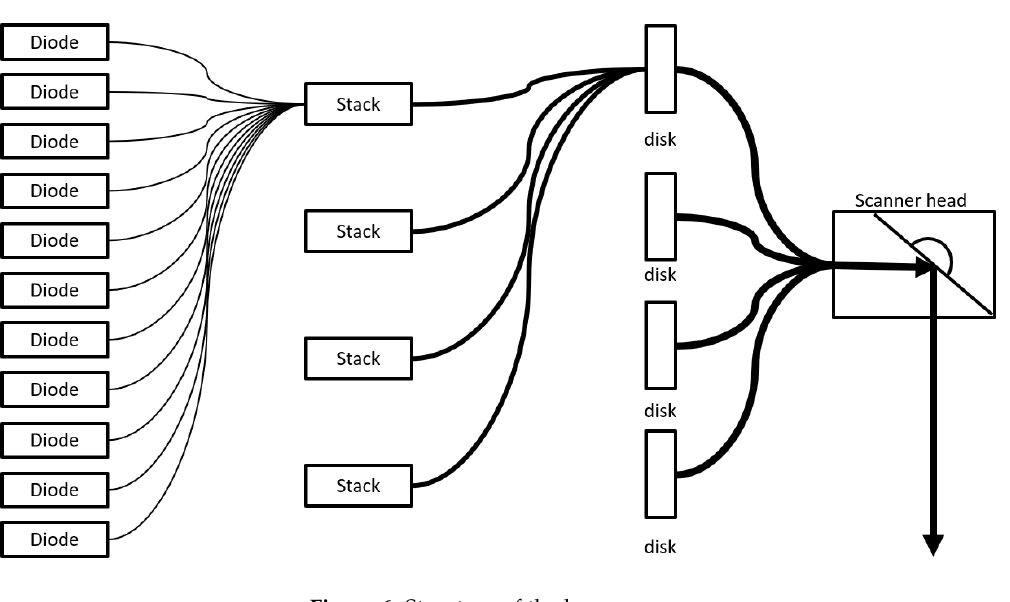
Figure 6. Structure of the laser